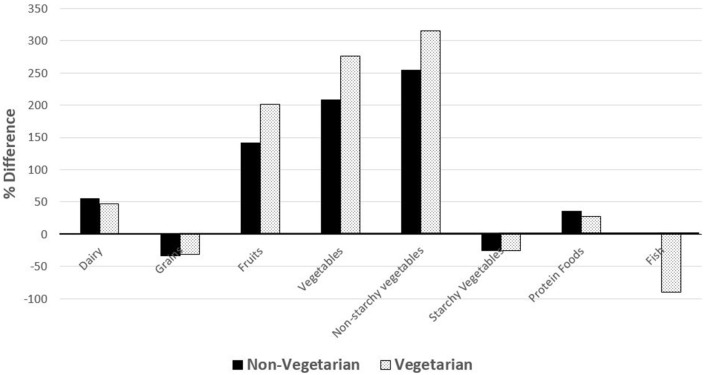
Percent difference in nutrient intake of vegetarian and non-vegetarian participants compared to the average US adolescent population intake. Comparisons were made with nutrient intakes of adolescents from What We Eat in America, NHANES 2011–2012 for US population ages 12–19 years (31). Bars above the 0 horizontal line means greater intake while bars below the 0 horizontal line means lesser intake for participants compared to the reported intakes of the reference US adolescent population.